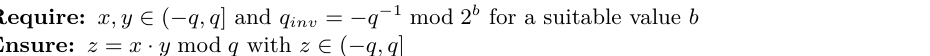
Figure 4: Dataflow diagram of the ModMul module. Register buffers are shown as small blue boxes in the diagram. Algorithm 6 Signed modular multiplication with Montgomery